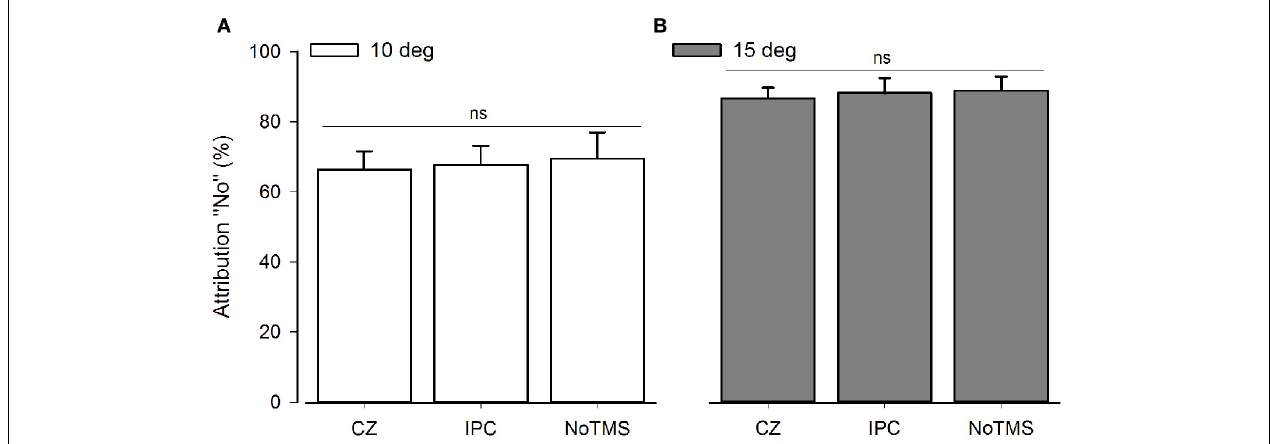
Table 1 | Kinematic.